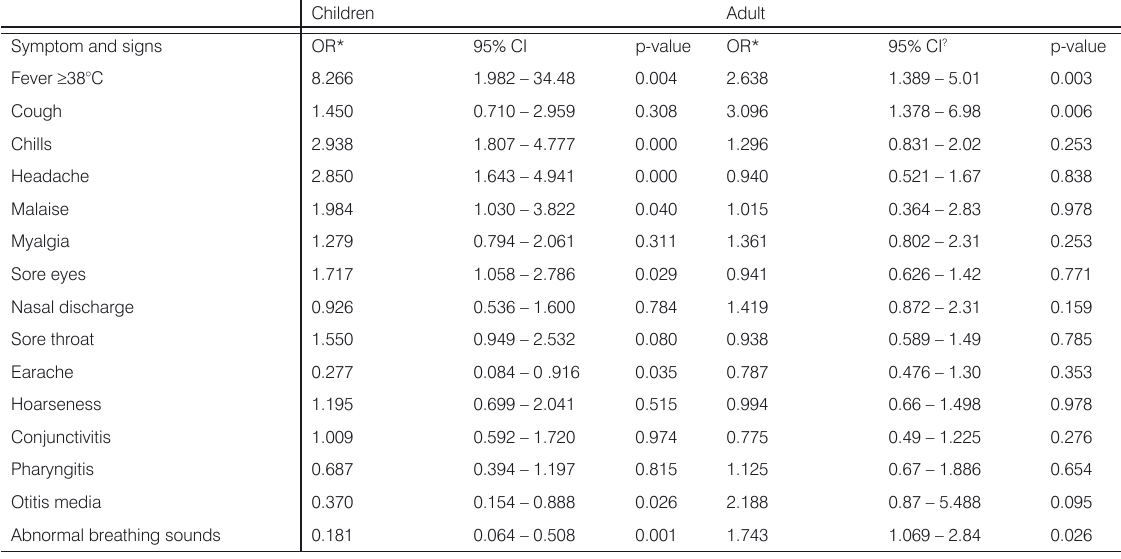
Table 2. Univariate logistic regression of clinical symptoms and signs of influenza-positive children and adults.